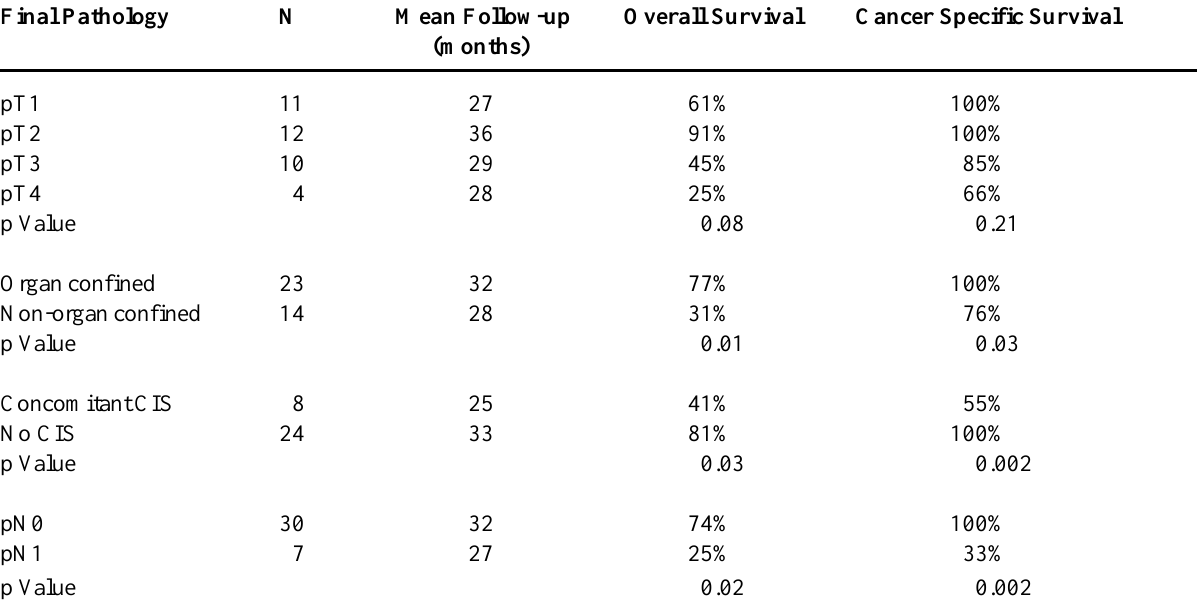
Table 3 – Sub-group analysis of overall and cancer-specific survival in 37 patients undergoing laparoscopic radical